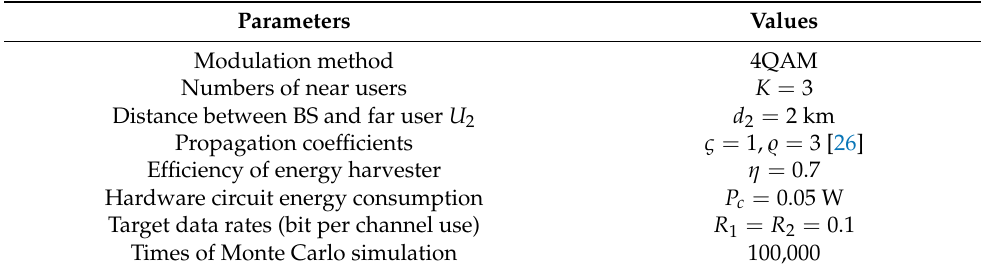
Table 1. Parameters and corresponding values of simulations.